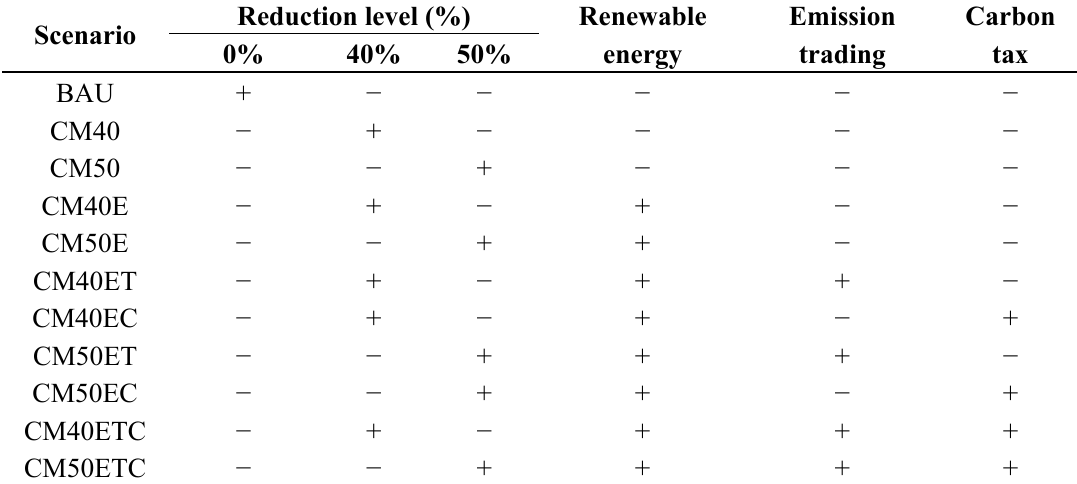
Table 3. CO 2 emission reduction measures in all